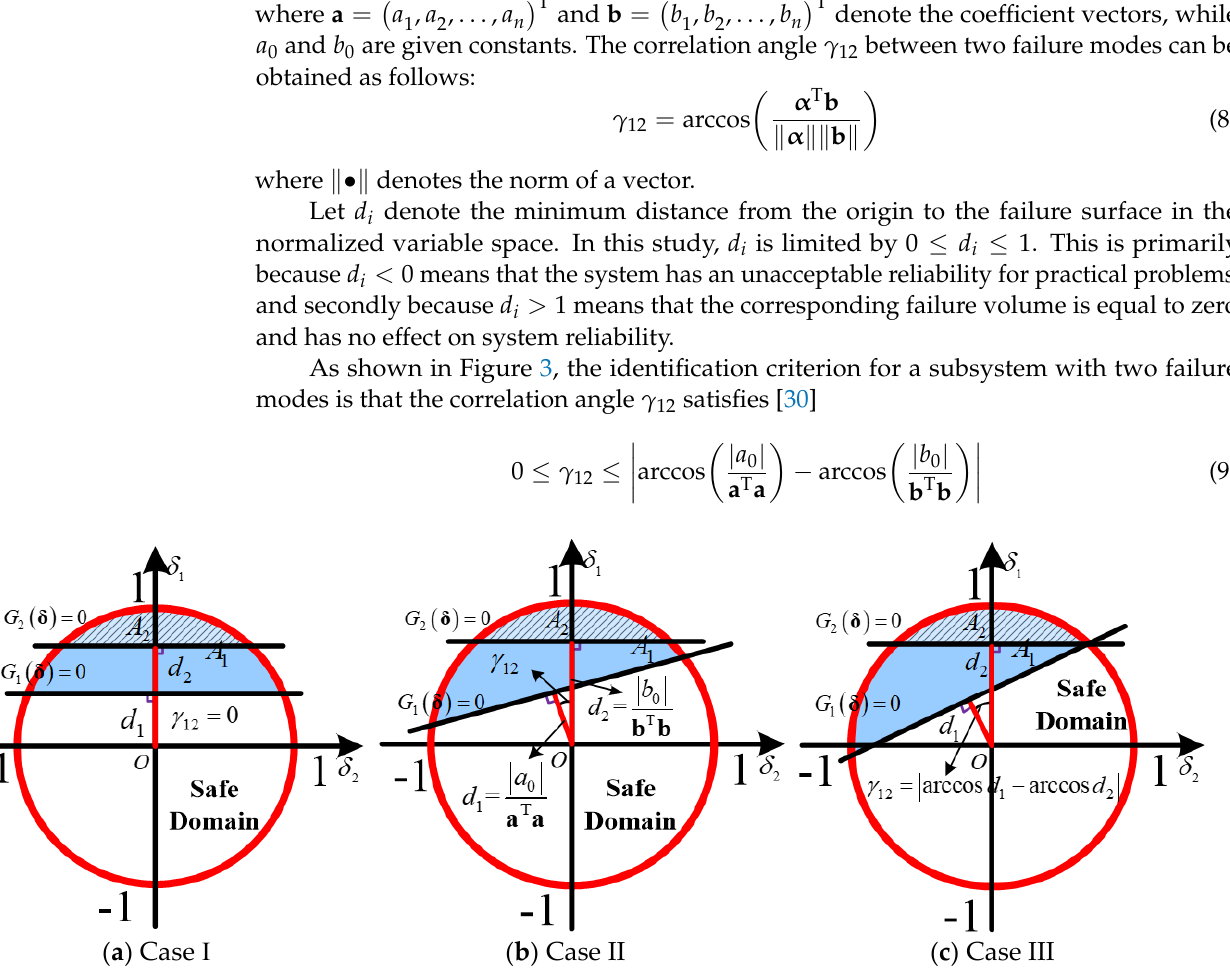
Figure 3. Three different cases of a subsystem with two failure modes: ( a , c ) Redundant failure mode critical cases. ( b ) Redundant failure mode general case.